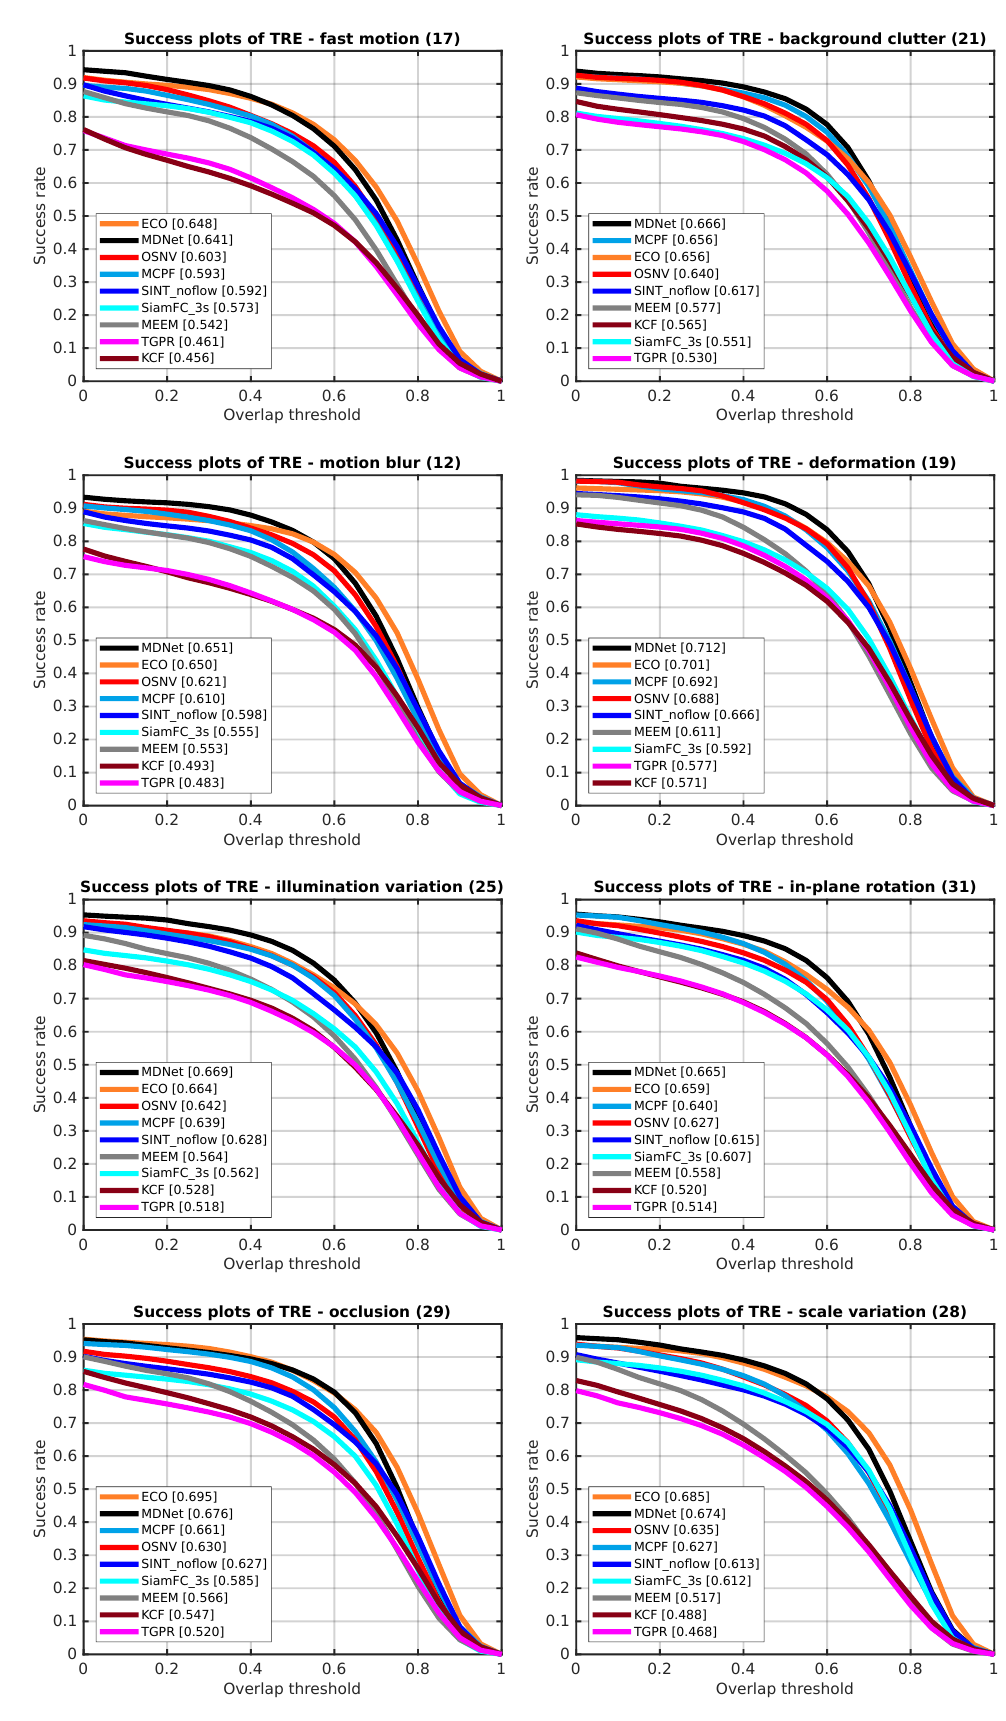
Figure 6. The attribute-based evaluation results of TRE with nine tracking algorithms on